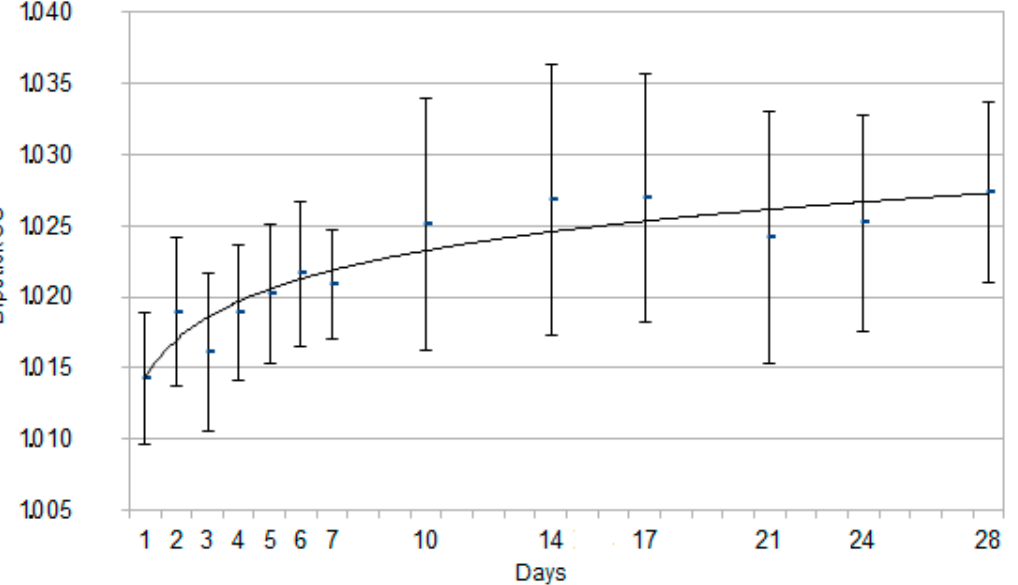
Figure 1. Graph for each time point representing Specific Gravity (SG) measured by dipstick, expressed as mean ± SD, in the 48 Great Dane puppies from birth to 28 days of age. The continuous curve represents the tendency line for this parameter.